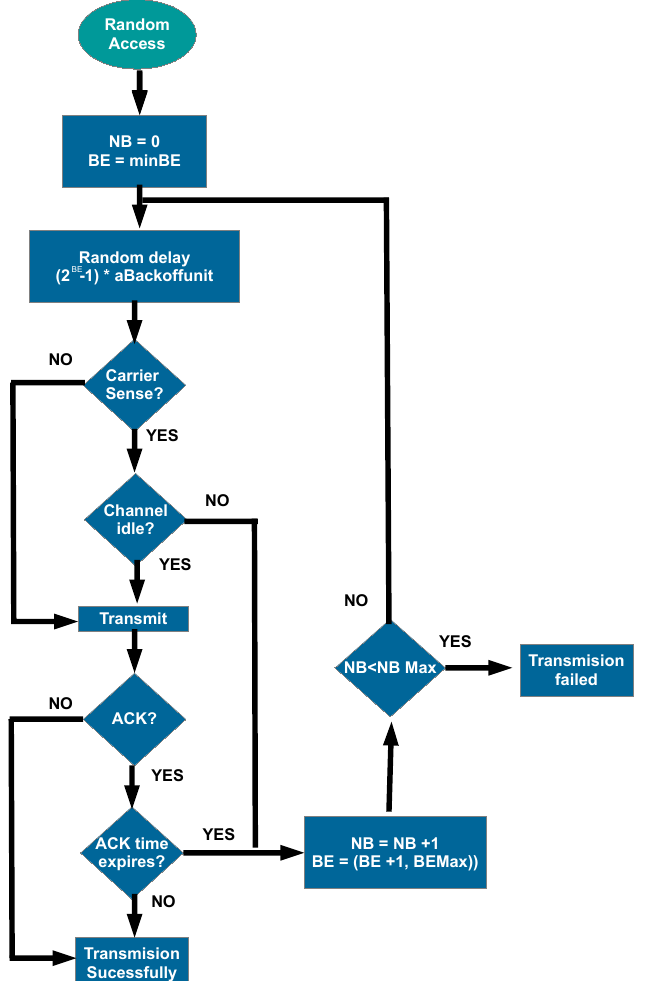
Figure 3. The transmission algorithm during CAP in standard IEEE